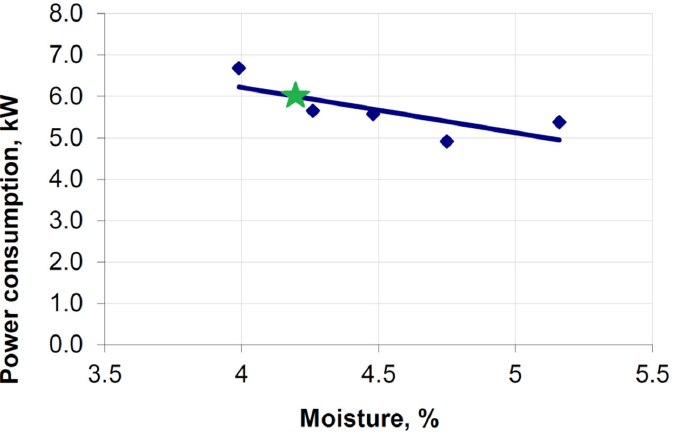
Figure 15. Influence of moisture content on energy consumption during briquetting of a mixture based on copper ore concentrate at peripheral speed of rollers v = 0.15 m/s [55]: the green star is moisture is 4.2%.